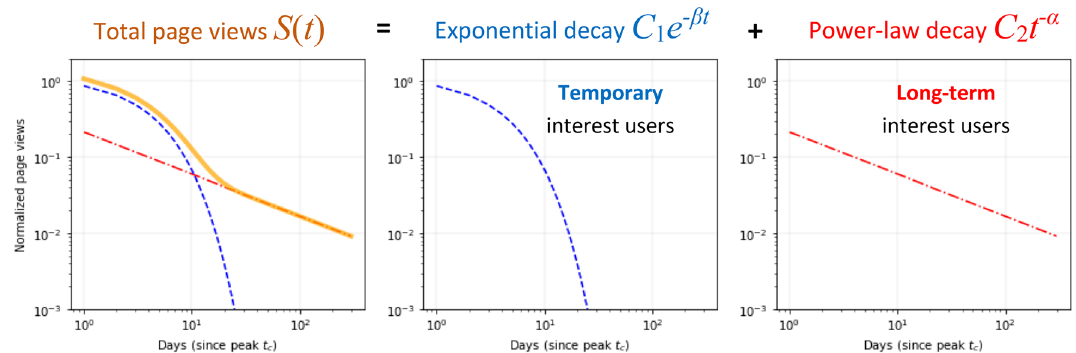
Figure 2. Proposed two-phase model of collective memory decay. The model consists of exponential decay, which corresponds to temporal interest users without interactions, and power-law decay, which corresponds to long-term interest users with